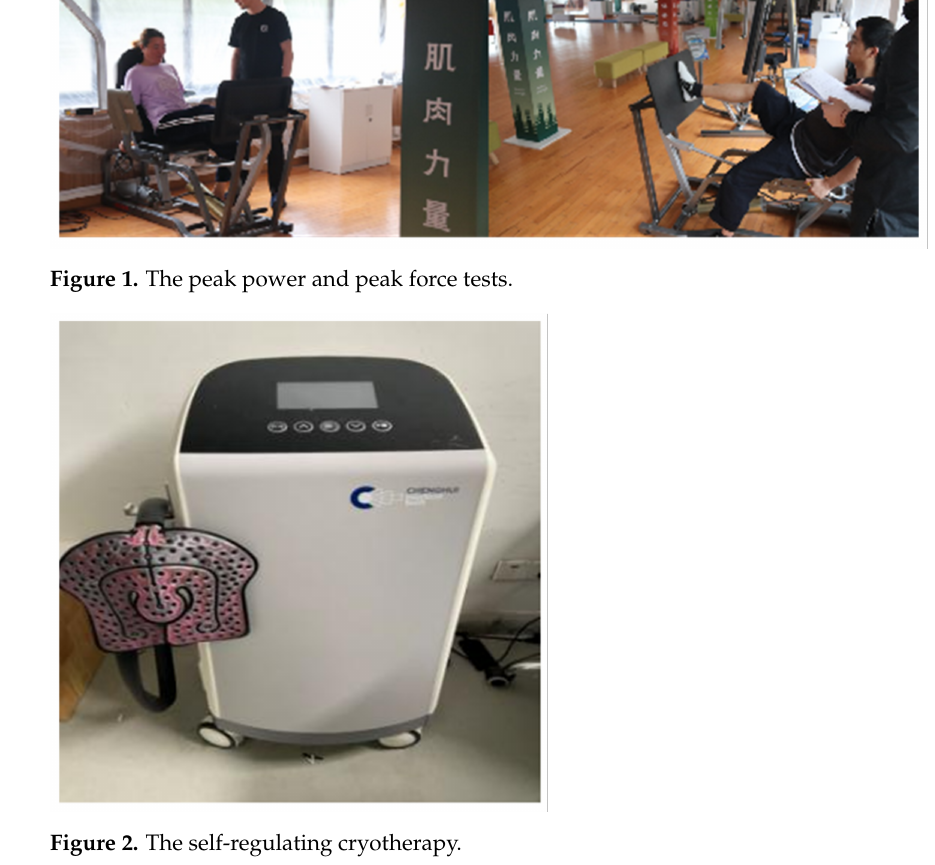
Figure 2. The self-regulating